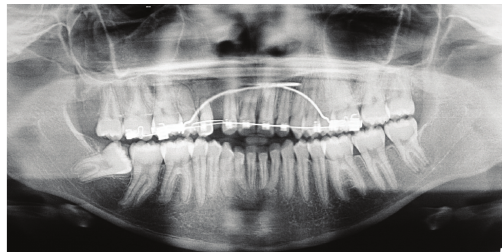
Figure 4: Final panoramic radiography: upper right canine posi- tioned in the dental arch showing reduced root